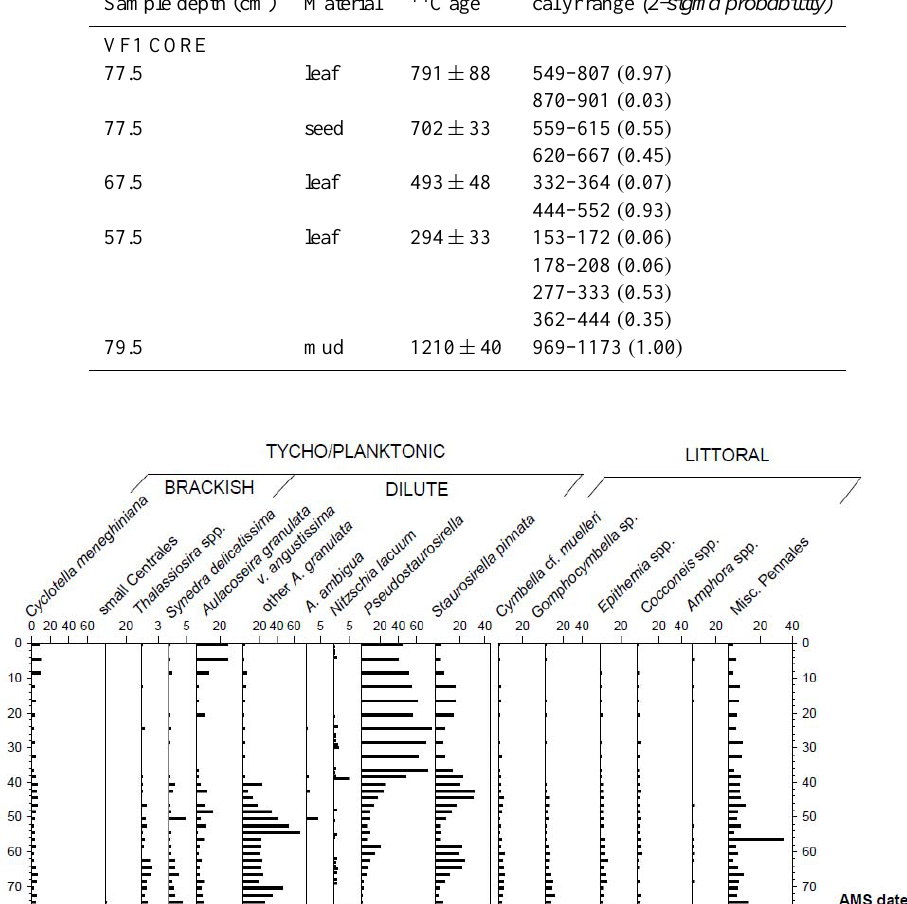
124 cm; Fig. 8d). Percentages of epiphytic diatoms were most abundant ∼ 1100–960 cal yr BP (122–116 cm), declin- ing gradually thereafter (Fig. 8e). Percentages of tycho- planktonic (but normally benthic) Pseudostaurosirella and Staurosirella increased notably during the last century (up- per 40 cm; Fig.